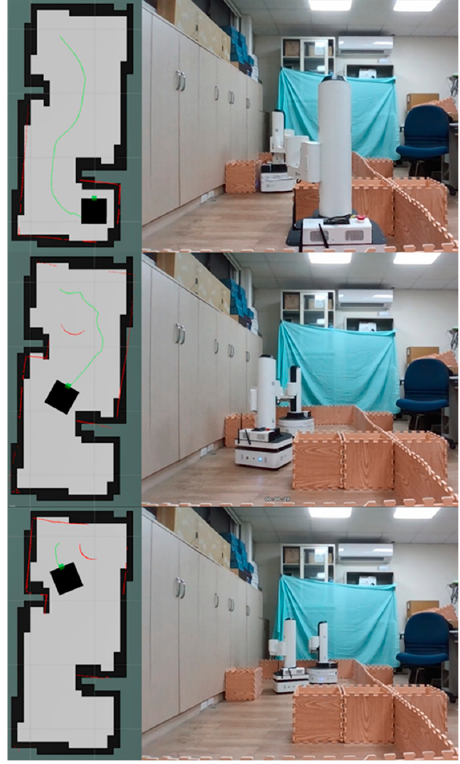
Figure 14. The path planning result in the environment with an unknown moving obstacle by MDP.